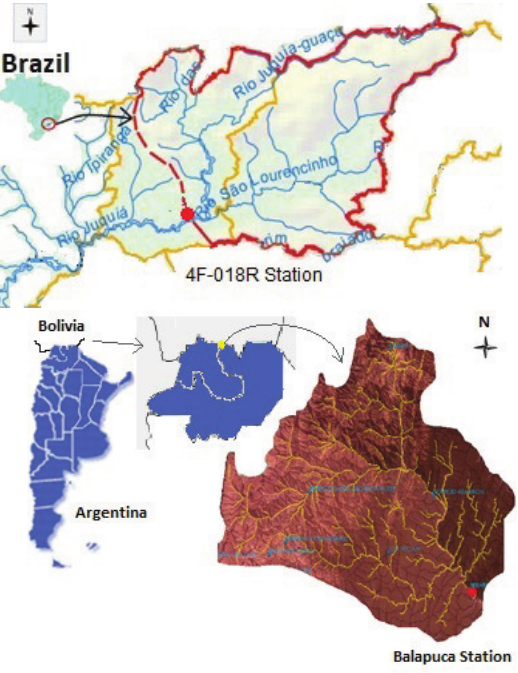
Figure A1. River basins studied in this